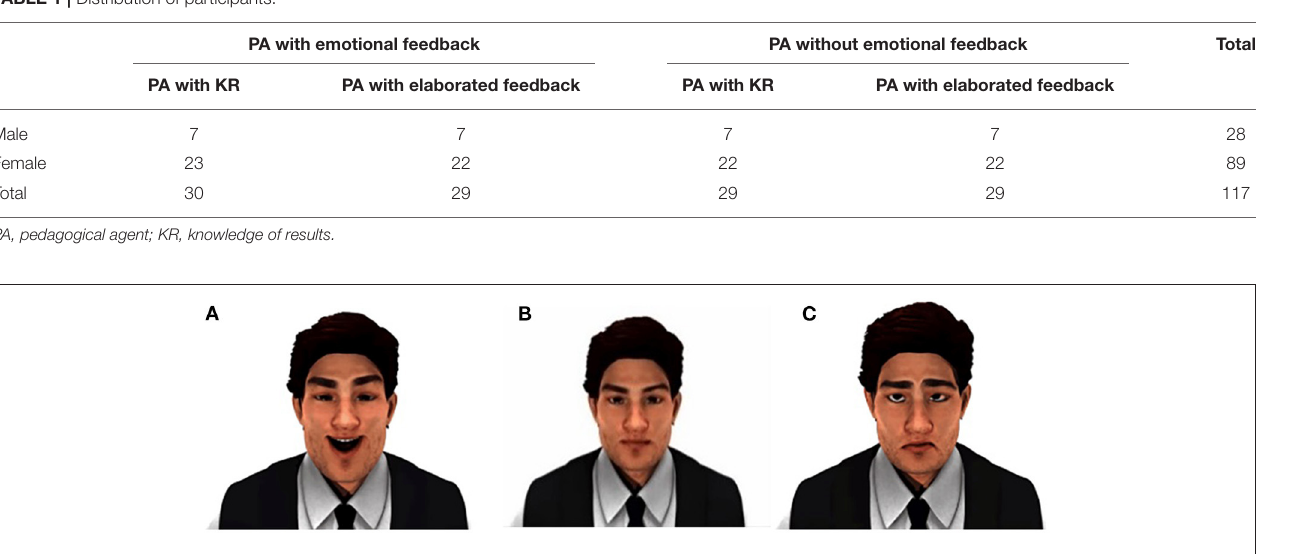
FIGURE 1 | Facial expressions of PA: (A) pleasure; (B) neutral; (C)